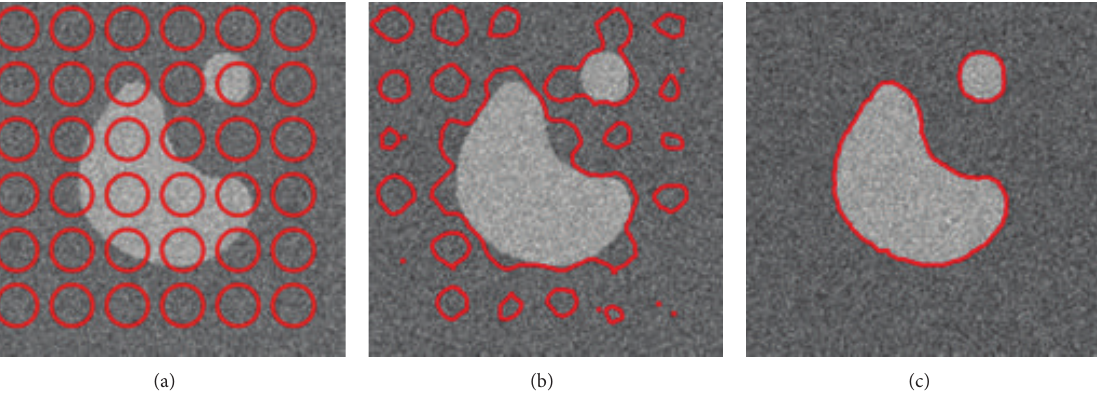
Figure 7: Segmentation results: comparison between KL-divergence-based approach and our method. (a) Original noisy image (Gaussian noise) and initialization of the segmentation process, (b) segmentation result with KL divergence, and (c) segmentation result with proposed approach ( 𝜉 = 1 , 𝛽 = 1 , 𝜎 = 0.1 ).